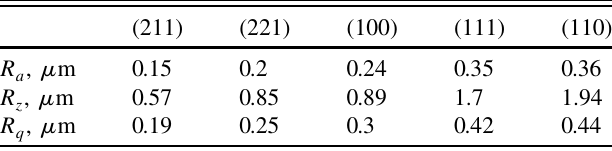
TABLE I. Surface roughness R a (arithmetic average of abso- lute values), R z (average distance between the highest peak and lowest valley in each sampling length), and R q (root mean squared values) of samples of the central crystals with different orientations.